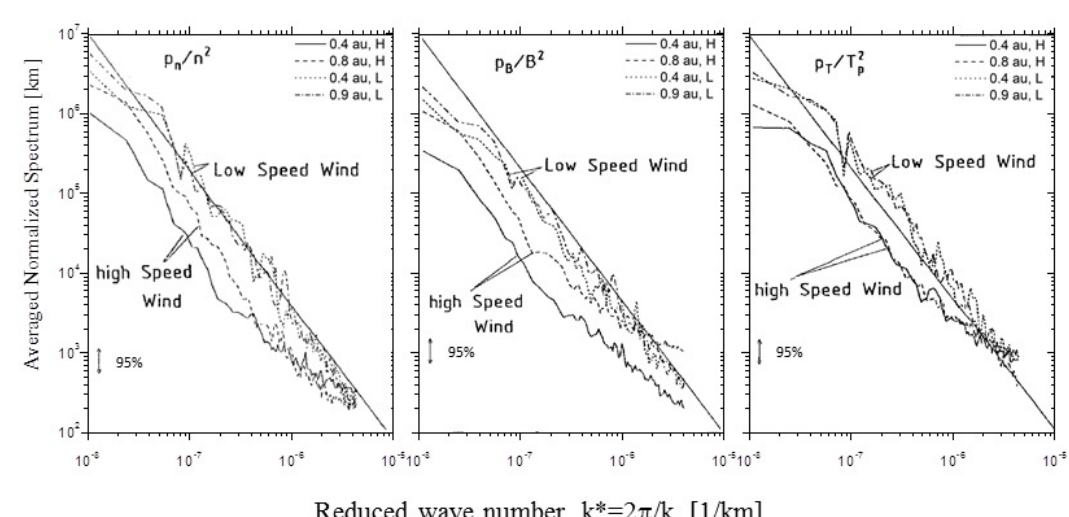
Figure 72: From left to right: normalized spectra of number density, magnetic field intensity fluctuations (adapted from Marsch and Tu, 1990b), and proton temperature (adapted from Tu et al. , 1991). Different lines refer to different heliocentric distances for both slow and fast